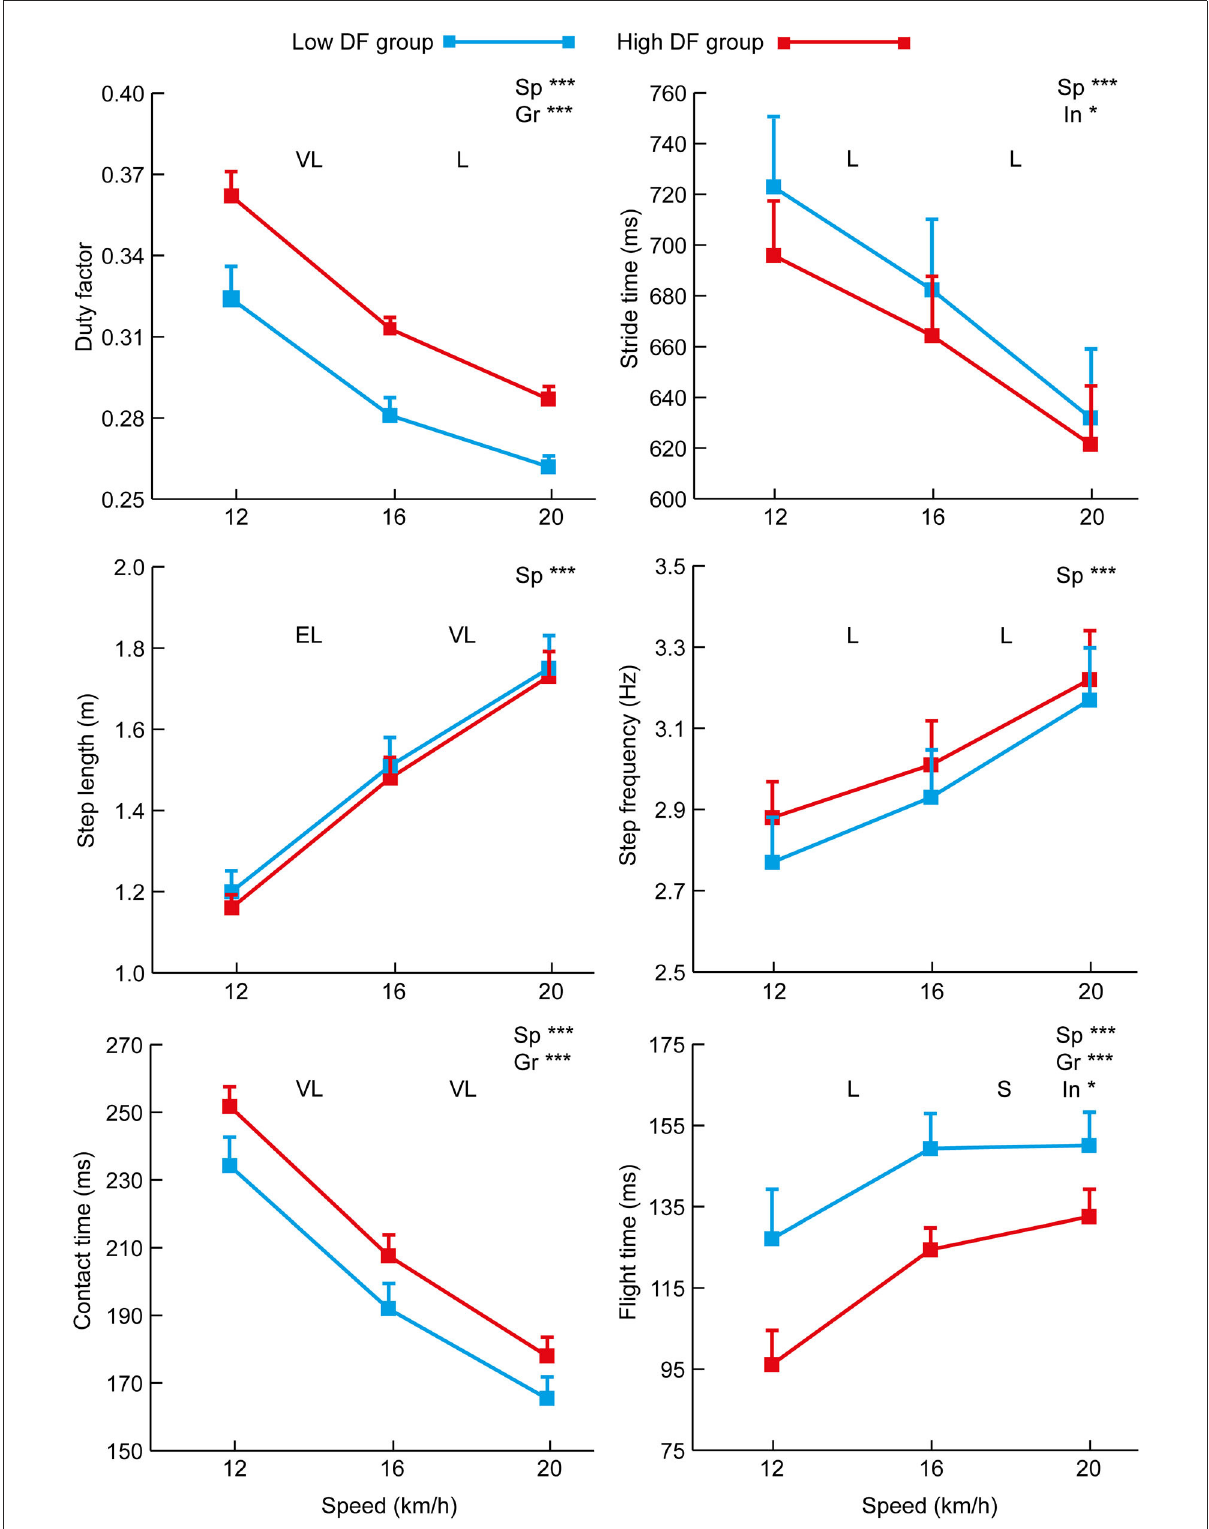
FIGURE1 Mean ( + SD) values for spatiotemporal data at each of the three testing speeds for the high and low DF groups. Overall effects for speed (“Sp”), group (“Gr”) and interaction (“In”) are annotated on each figure where statistically significant ( p < 0.05 *, p < 0.01 **, or p < 0.001 ***). The effect size (Cohen’s d ) for differences between successive test speeds is annotated as small (S), moderate (M), large (L), very large (VL), or extremely large